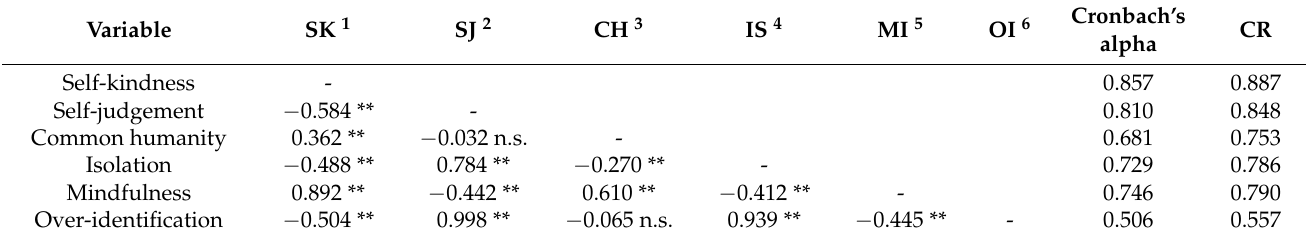
Table 5. Cronbach’s alpha, CR and bivariate correlations for the Spanish